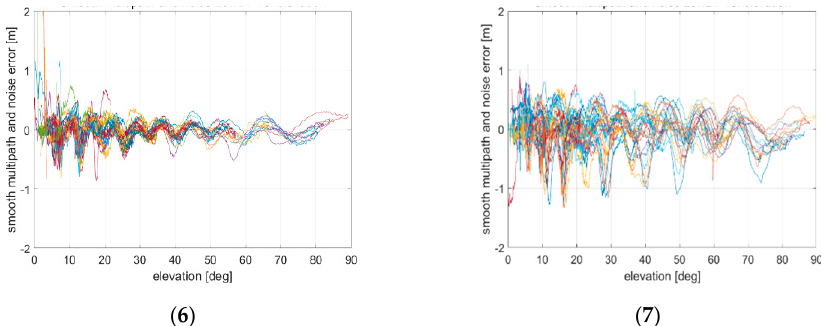
Figure A14. The 100 s smoothed multipath (estimated through CMC) at L5/E5a for the antennas measured at DLR; from left to right, from top to bottom: ( 1 ) Leica AR25 R4; ( 2 ) Novatel GNSS-750; ( 3 ) Javad RingAnt-DM; ( 4 ) Space Engineering GalExpAnt; ( 5 ) DLR internal design; ( 6 ) Navxperience Nav3G+C; ( 7 ) Tallysman VSE6028 VeroStar. Different colors indicate different PRNs.